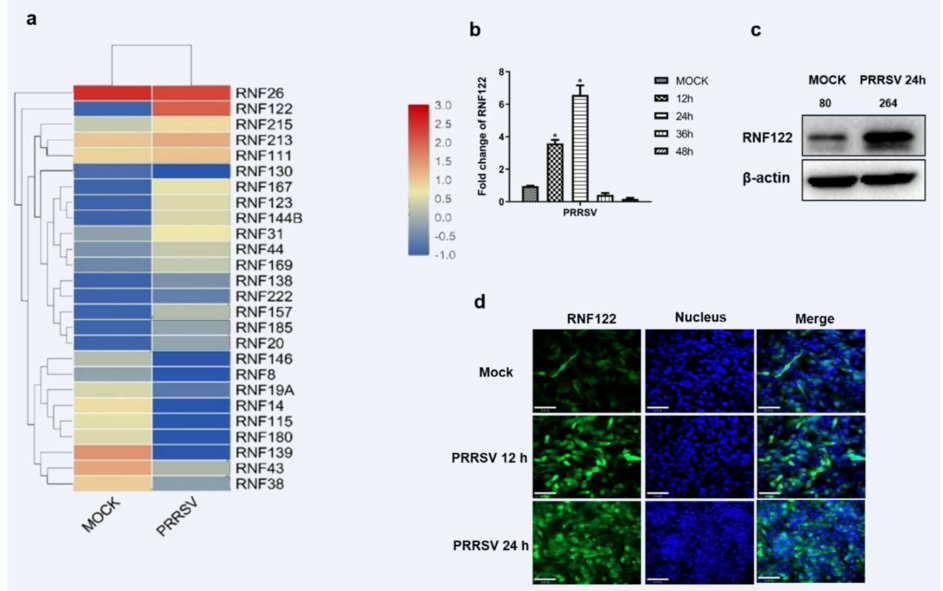
Figure 1. Porcine E3 ubiquitin ligase RNF122 was up-regulated after PRRSV infection. ( a ) Heat map of differential expression of E3 ubiquitin ligase in RING domain family after PRRSV infection. ( b ) 3D4/21 cells were infected with PRRSV (MOI = 0.5), and the cells were harvested at different time points for qRT-PCR detection to analyze the expression of RNF122. ( c ) 3D4/21 cells were infected with PRRSV (MOI = 0.5), and ( d ) the expression of RNF122 was observed by fluorescence microscopy at different time points. * p < 0.05 (analysis of two-way ANOVA attended by Bonferroni post-test). Data are representative of three independent